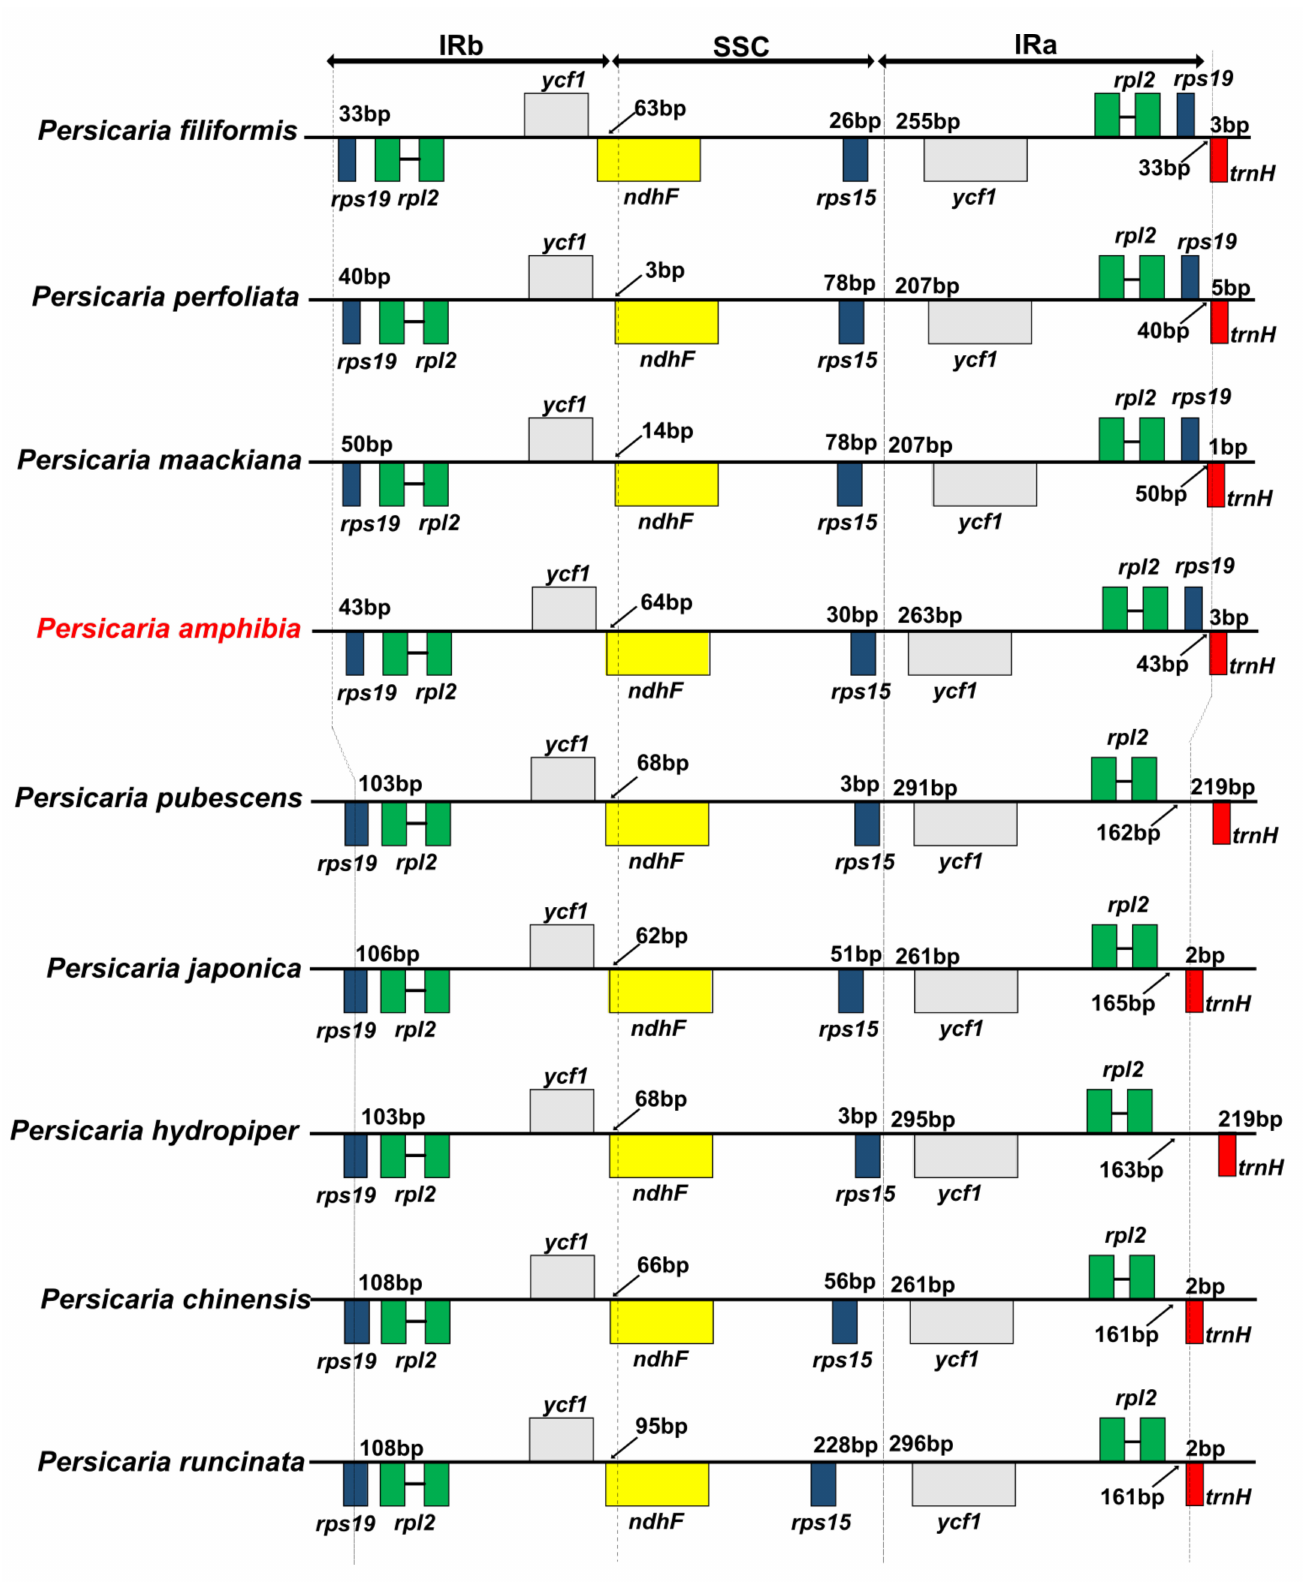
Figure 3. Comparison of the LSC/IR and IR/SSC junction among nine Persicaria cp